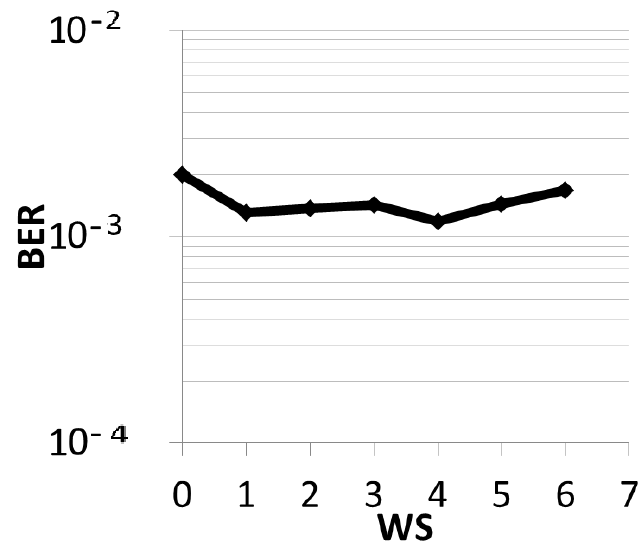
Figure 4. BER versus WS for 75 km (3 spans of 25 km of SSMF) and OSNR of 36 dB without considering any SOA placed inline.